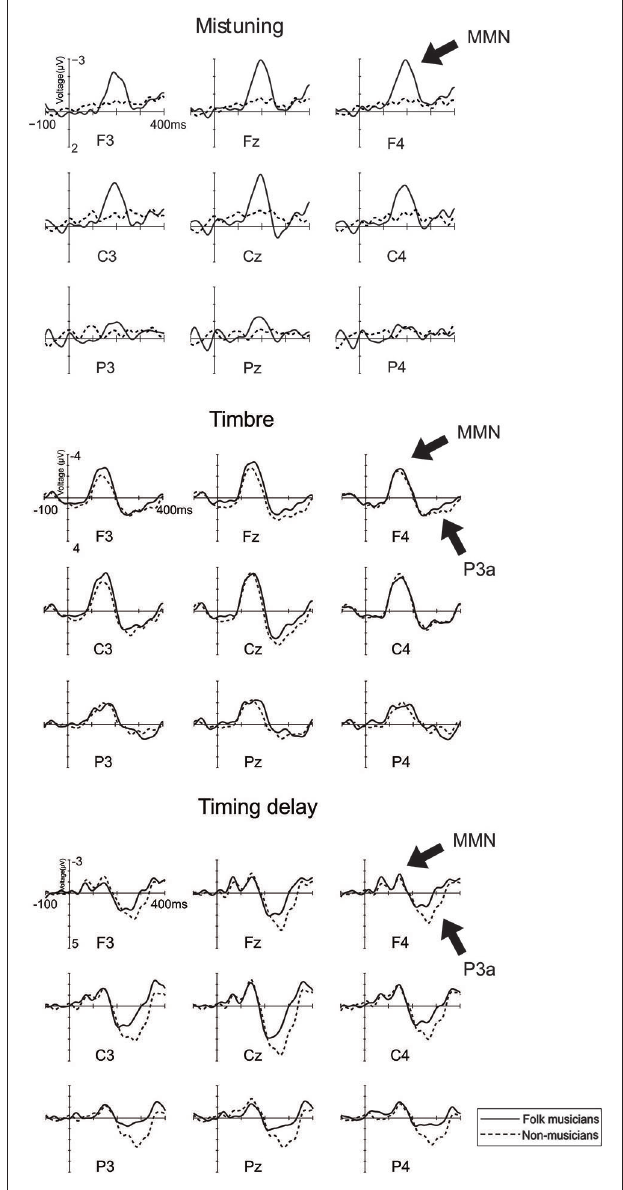
FIGURE 2 | Brain responses (ERP to deviant melody subtracted from the ERP evoked by the standard melody) in Folk musicians (continuous line) and Non-musicians (dashed line) to Mistuning, Timbre, and Timing delay . These changes were introduced in the melody but they did not modulate the continuation of the